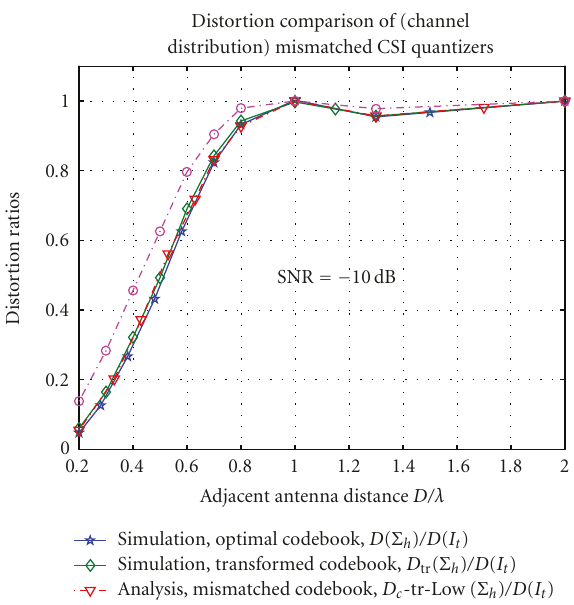
Figure 3: Normalized capacity loss (with respect to the capacity loss of uncorrelated fading channels) comparison of a 3 × 1 MISO transmit beamforming with optimal and transformed codebooks versus antenna spacing d = D/λ , in low-SNR regimes ( ρ = − 10dB).